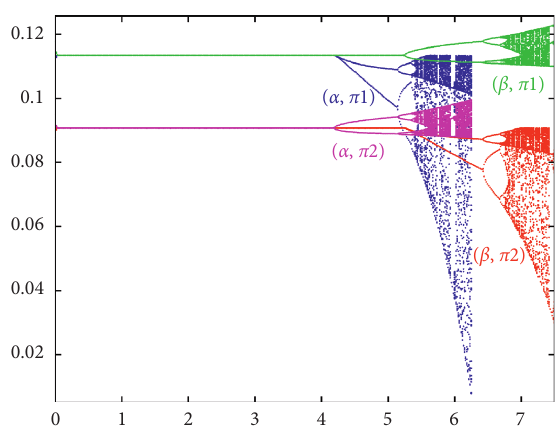
Figure 12: The bifurcation diagram of the profit under separate